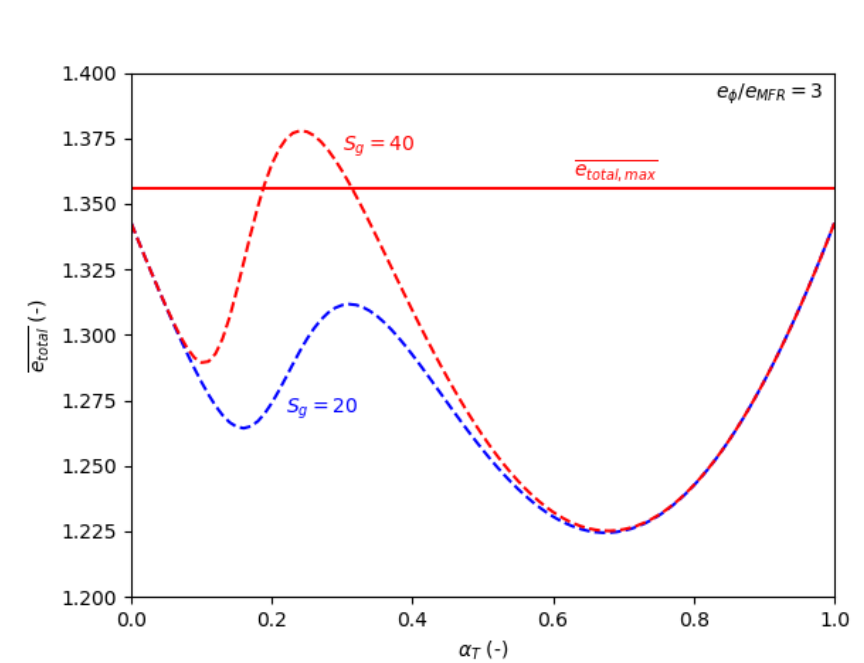
Figure 10. Illustration of the C1